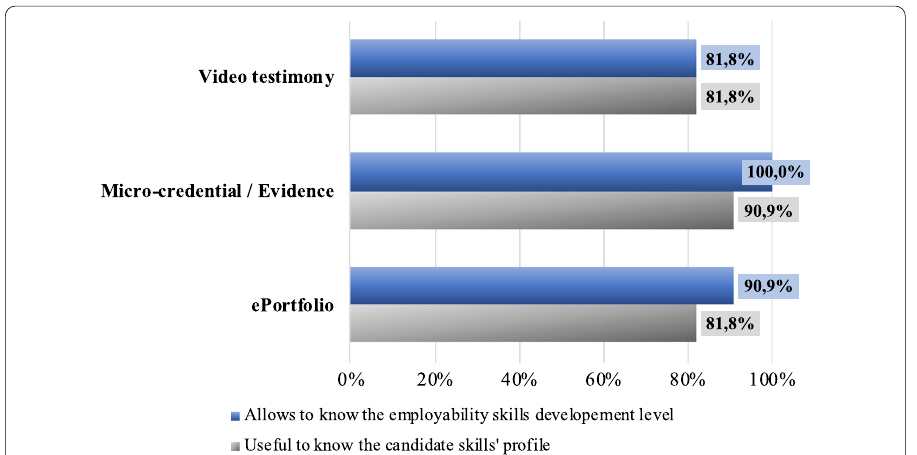
Fig. 5 Employer perceptions of students’ skills based on the artefacts presented. Total employers: 11. Percentage of agreement based on a 1–7 scale (1 Authors. EPICA